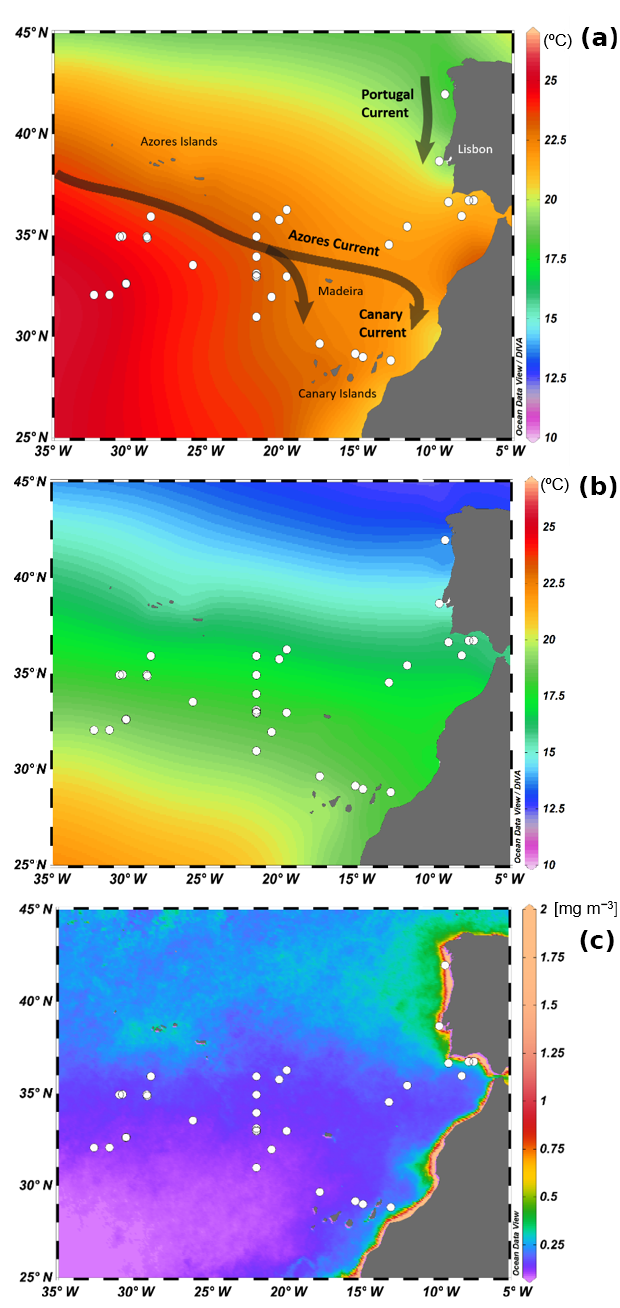
Figure 2. (a) Mean summer (July to September, from 1955 to 2012) SST (sea-surface temperature) (data from World Ocean Atlas 2013) with main surface currents shown by arrows, (b) mean winter (Jan- uary to March, from 1955 to 2012) SST (data from World Ocean Atlas 2013) and (c) mean monthly chlorophyll mgm − 3 data from 2010 to 2015 (data from the Goddard Earth Sciences Data and In- formation Services Center) in the studied region along with the po- sitions of the studied plankton net stations. Maps made with ODV (Schlitzer,